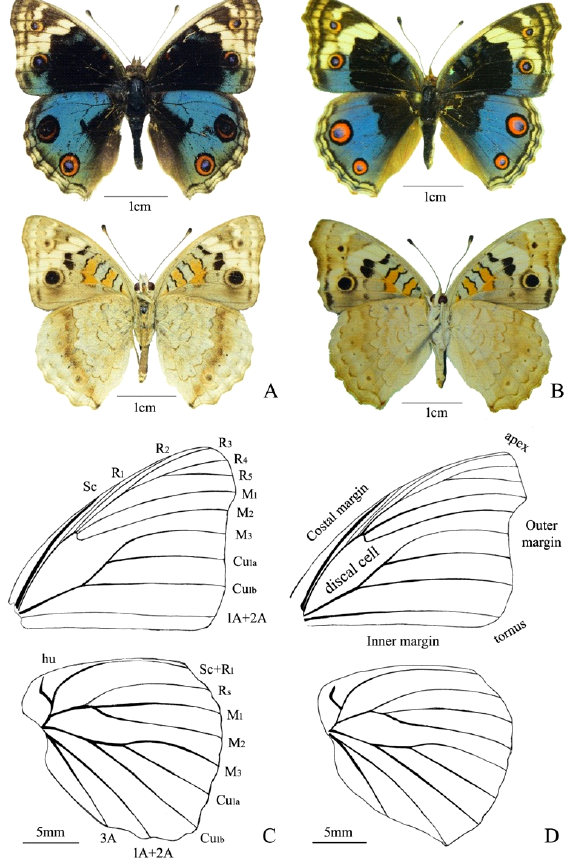
Figure 1. Junonia orythia (Linnaeus, 1758) A - male; B - female; C - wing venation (male); D - wing venation